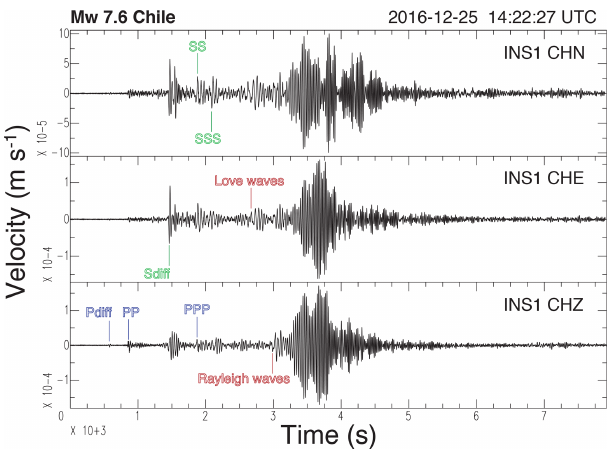
Figure 14. M w = 7 . 6 Chile earthquake of 25 December 2016 recorded by the three components of the INS1 seismic station. At the top right of the figure the origin time of the teleseism is reported. The theoretical arrival times of the most important recorded seismic phases are shown. The original horizontal components were rotated anticlockwise by an angle of 307.8 ◦ with respect to the north, ac- cording to the computations described in detail in Sect.